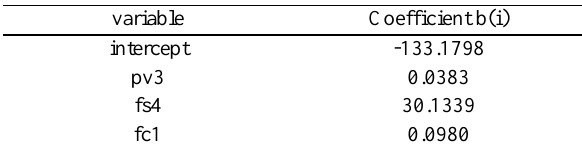
Table 8 Parameters of the logistic regression